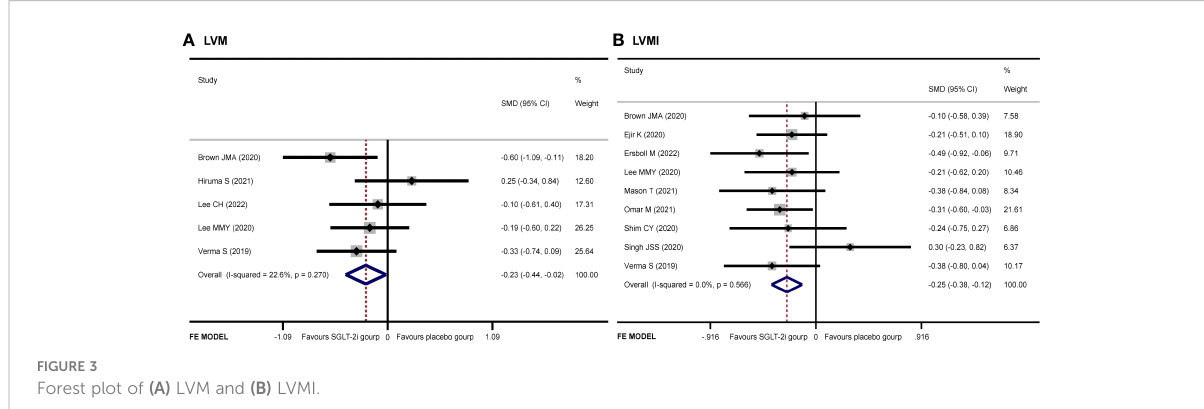
FIGURE 3 Forest plot of (A) LVM and (B) LVMI.